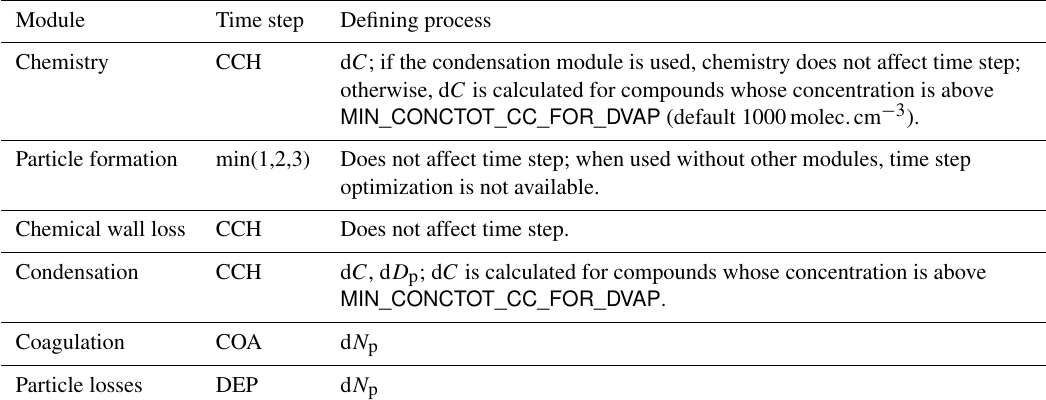
Table 1. Time step